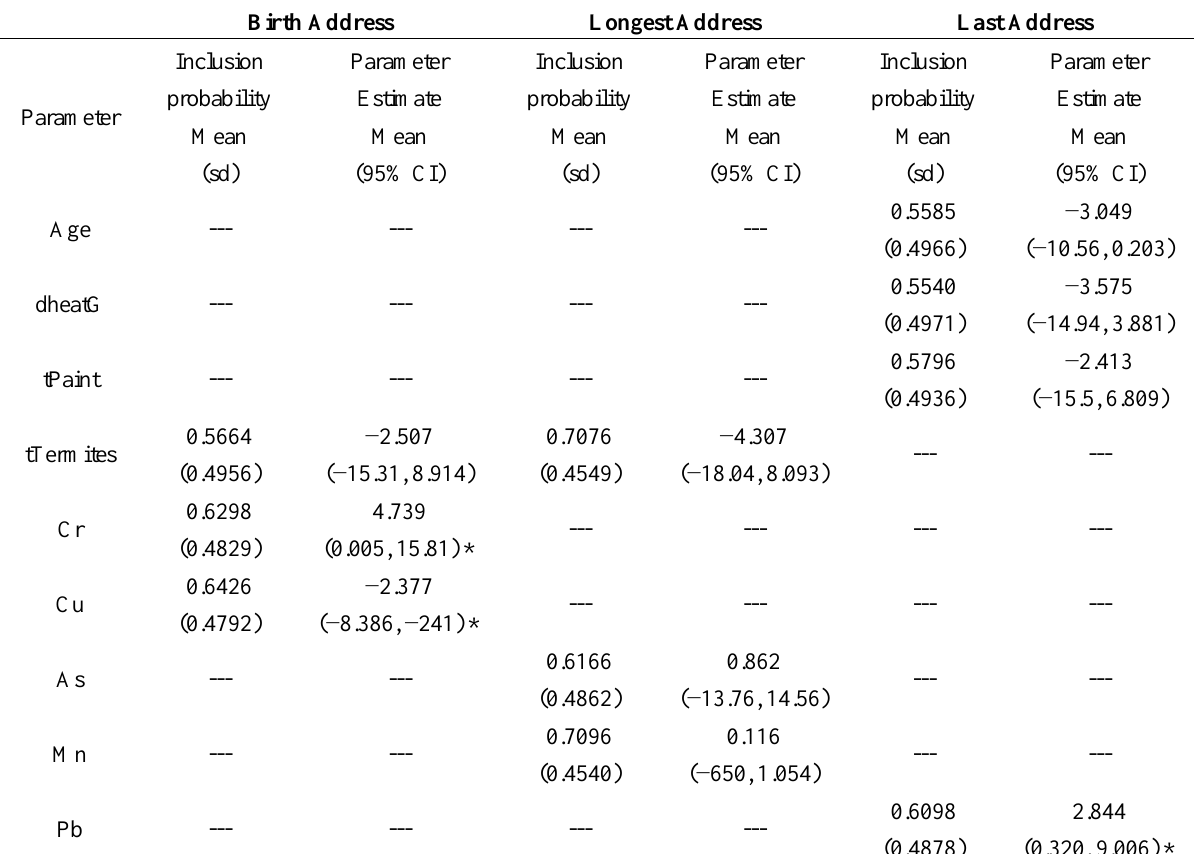
Table 5. Inclusion probability posterior mean and standard deviation as well as mean parameter estimate and 95% credible interval from Kriging broken down by first, longest, and last address from the validation